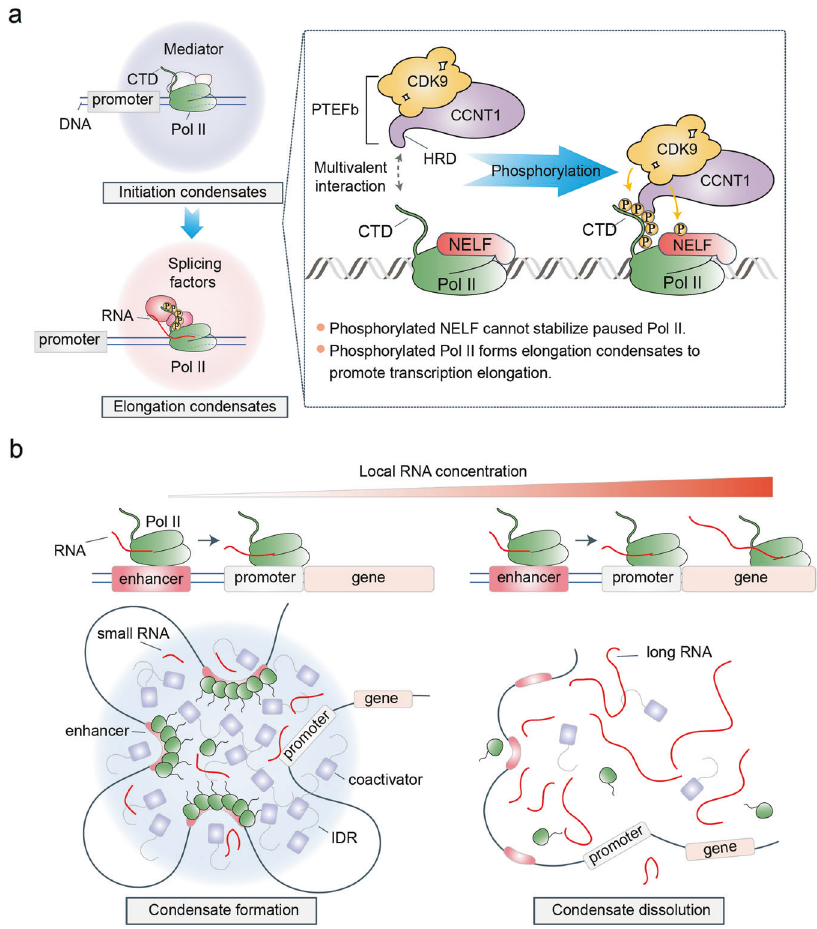
Fig. 4 The function of LLPS in regulating gene transcription. a Phosphorylation regulates the transformation of initiation condensates to elongation condensates. In transcriptional initiation, RNA polymerase II (Pol II) phase-separates various factors with IDRs, such as transcription factors and coactivators, to form initiation condensates. After the transcription initiation, Pol II does not directly enter the elongation phase but pauses in a region approximately 50 bp downstream of the transcription start site, which is called promoter-proximal pausing. Thereafter, PTEFb can phase-separate into the initiation condensates through the multivalent interactions between the histidine-rich domain and carboxy-terminal domain (CTD) of Pol II. Therefore, CDK9, a subunit domain of PTEFb, can phosphorylate the negative elongation factor (NELF) and CTD. Phosphorylated NELF cannot stabilize paused Pol II and phosphorylated Pol II forms elongation condensates by hyperpho- sphorylated CTD, thereby achieving transcription elongation. b The transcriptional condensates can also be formed at a super-enhancer. Besides, the local RNA concentration can negatively regulate the formation of super-enhancer condensates. Low levels of RNA at regulatory DNA elements promote the formation of transcriptional condensates, whereas high levels of RNA from gene transcription can dissolve the transcriptional